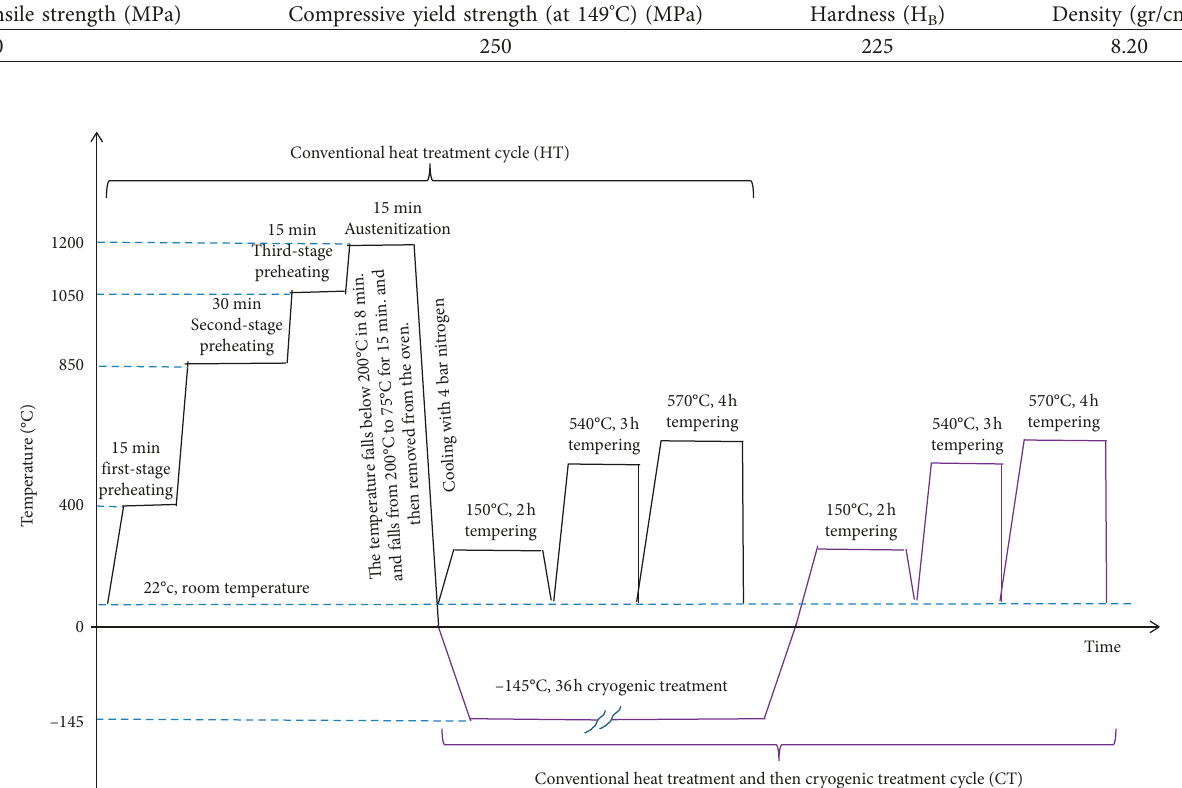
Figure 3: Heat treatment schema of AISI M2 punches.